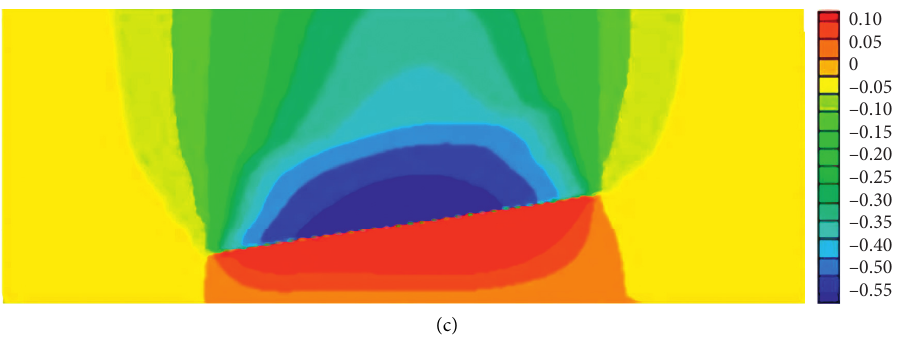
Figure 6: Vertical displacement distribution along the inclined direction in the mining of the rock-coal composite protective layer. (a) Working face is advanced to 40 m; (b) working face is advanced to 120 m; (c) working face is advanced to 200 m.